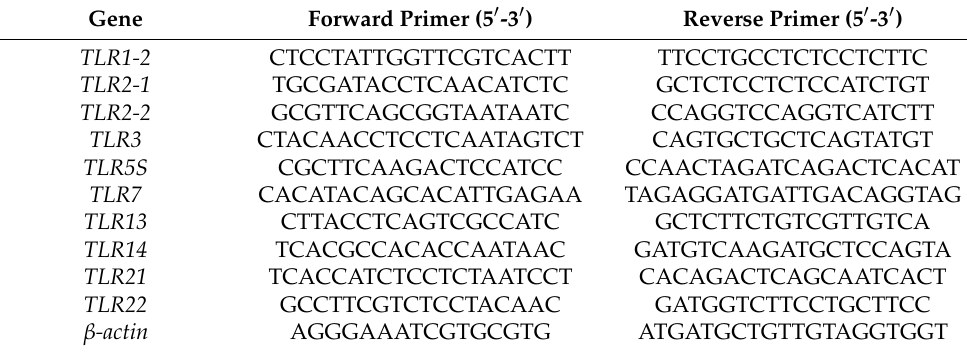
Table 2. Primers used in this